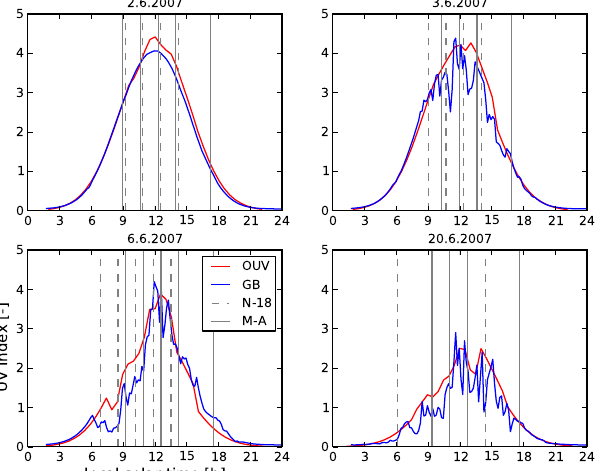
Figure 7. Average number of cloud observations per day obtained from AVHRR/3 using the operational combination of Metop-A with either NOAA-18 or NOAA-19 during the period from 1 June 2007 to 31 December 2012. The average is calculated from the interme- diate gridded cloud optical depth file (Fig. 6) for each month in 5 ◦ zonal bands. In the Antarctic region, the number of successful cloud observations is reduced due to high surface albedo. During the qual- ity control, the cloud observations over highly reflecting surfaces are ignored and clear-sky conditions are assumed (see Sect. 4.2.3).